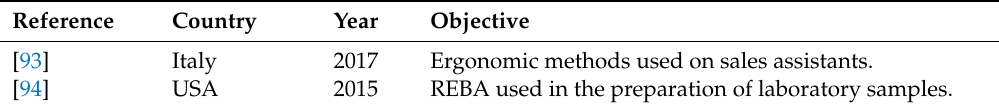
Table 8. Professional, scientific and technical